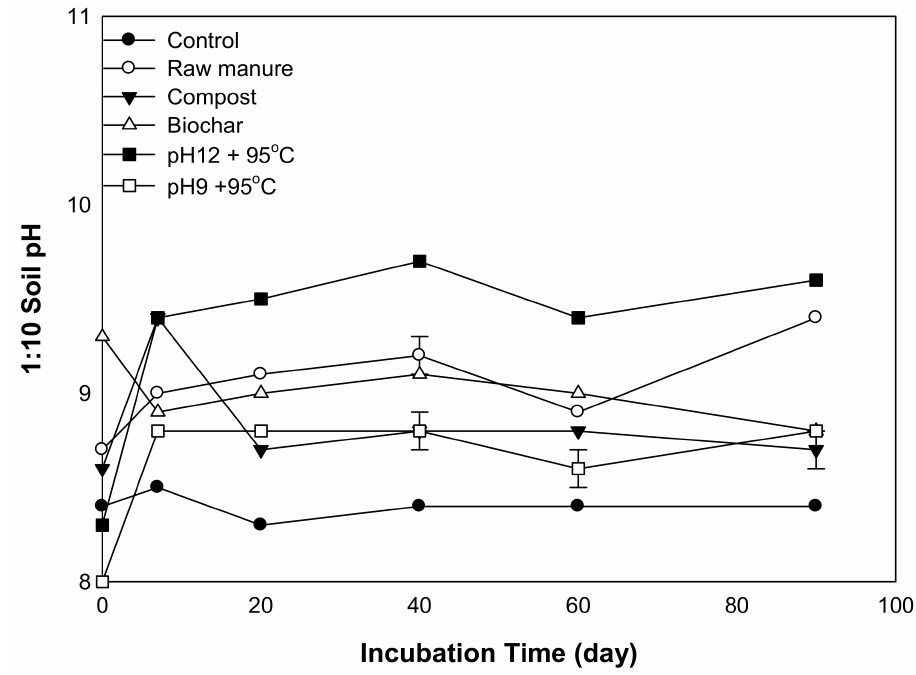
Figure 1. Variation in soil pH treated with different organic amendments derived from cow manure at different incubation